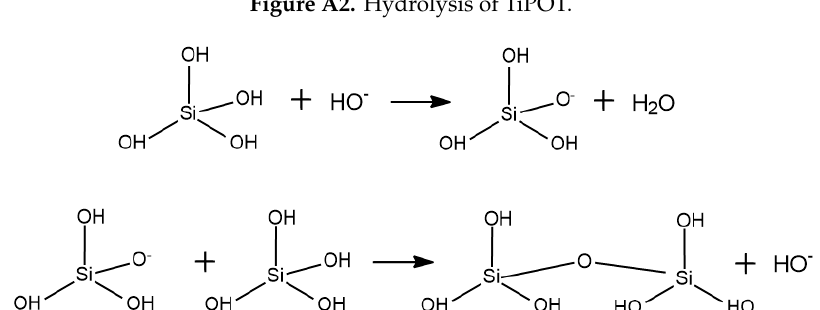
Figure A3. Two step homo-condensation: between orthosilic Si(OH) 4 molecules.